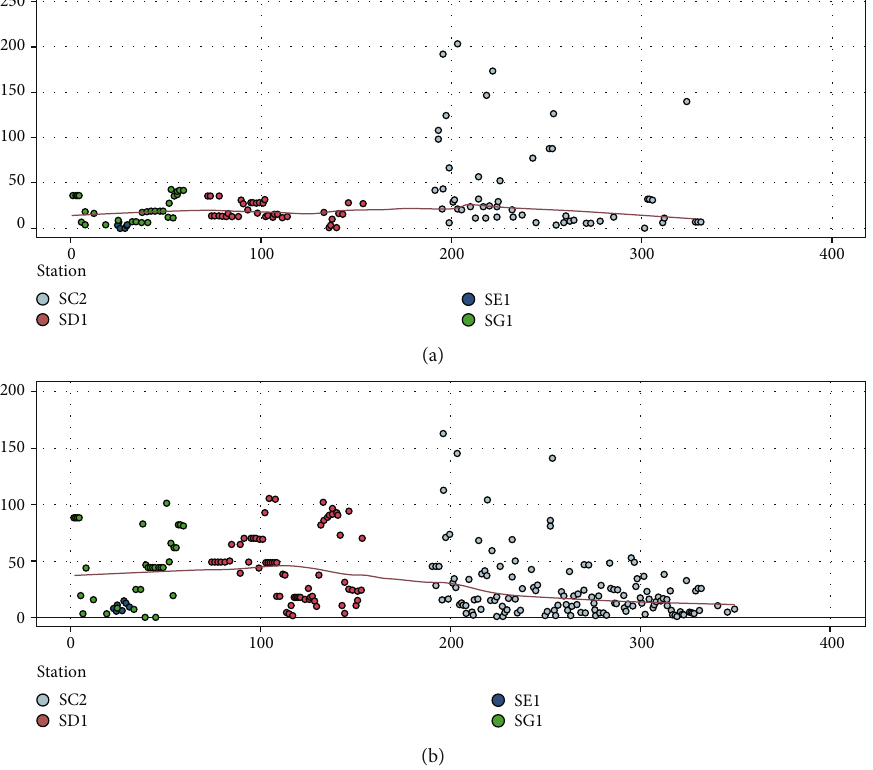
Figure 8: Digital signal analysis (simulated data) used in di ff erent ground veri fi cation test orders for this project. Number of signals ( y -axis) vs. test order ( x -axis): (a) digital inputs and (b) digital